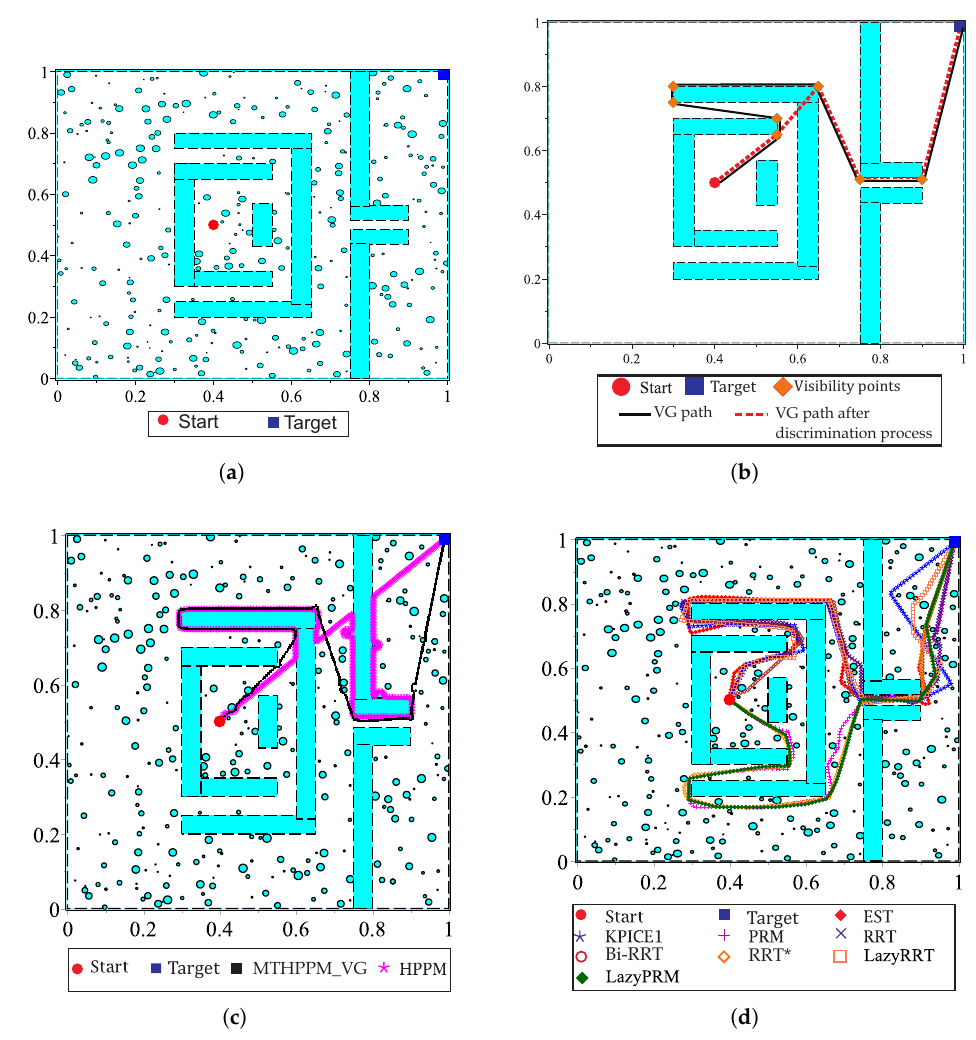
Figure 23. Comparative results for case study 4; best run of each SBP algorithm. ( a ) Path planning problem case study 4. ( b ) Visibility graph path without circular obstacles. ( c ) Paths obtained with HPPM and MTHPPM_VG. ( d ) Paths obtained with SBP